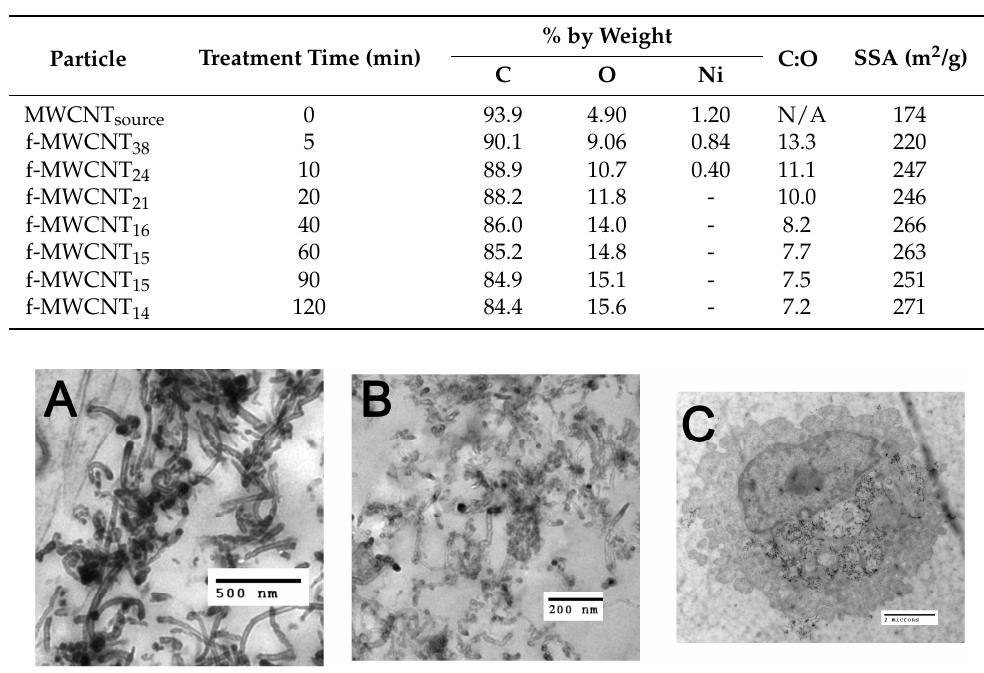
Figure 1. TEM images of particles and macrophage ingestion of MWCNTs: ( A ) TEM of source raw MWCNT; ( B ) TEM of carboxylated f-MWCNT 16.2 ; and ( C ) TEM of macrophage internalizing source raw MWCNT (50 μ g/mL) after 4 h.